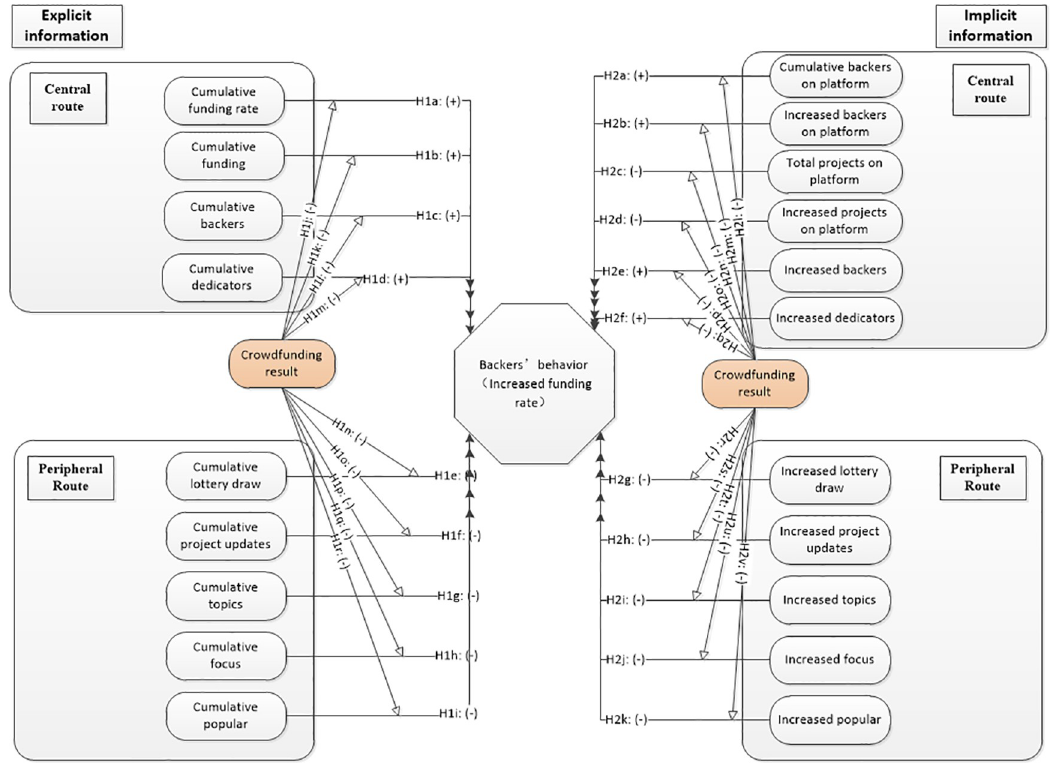
Fig 1. Project dynamic implicit/explicit factors frame based on ELM